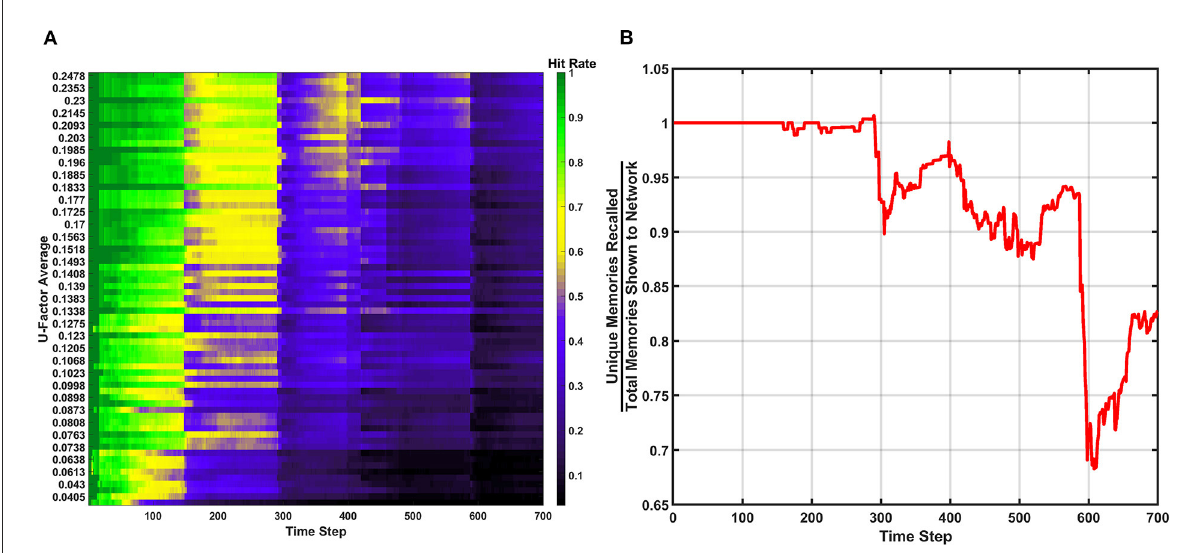
FIGURE9 Results of the erase behavior when R th = 200 v ON . (A) The hit rate takes multiple hits from successive erasure events through the entire simulation. Phases of post-erase recovery do appear but are erased over time due to the high amount of erasure events. (B) The unique memory ratio shows multiple drops as erasure events occur. The ratio attempts to recover multiple times, but often fails to do so due to subsequent erasure events happening at a rapid